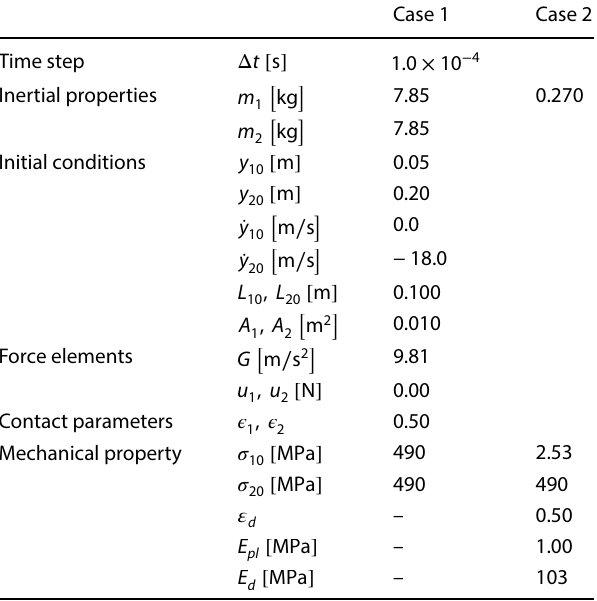
Table 1 Parameters for numerical analysis